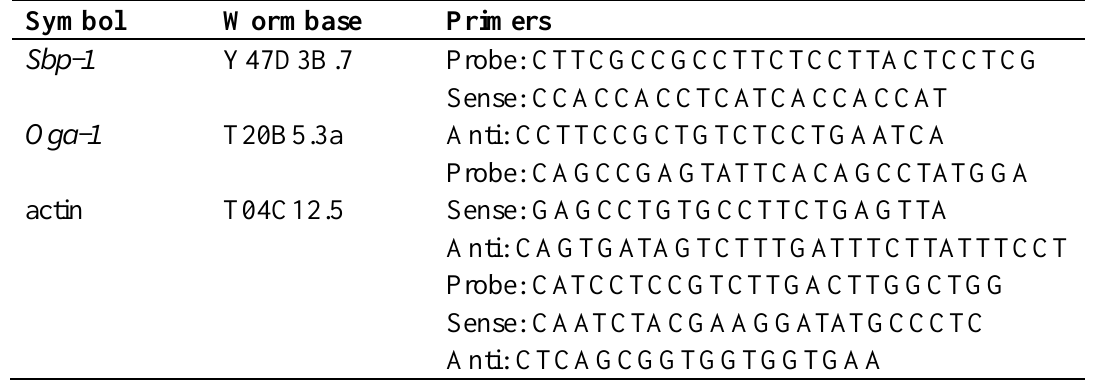
Table 2. Sequences and target positions of the primers used for quantitative RT-PCR in this